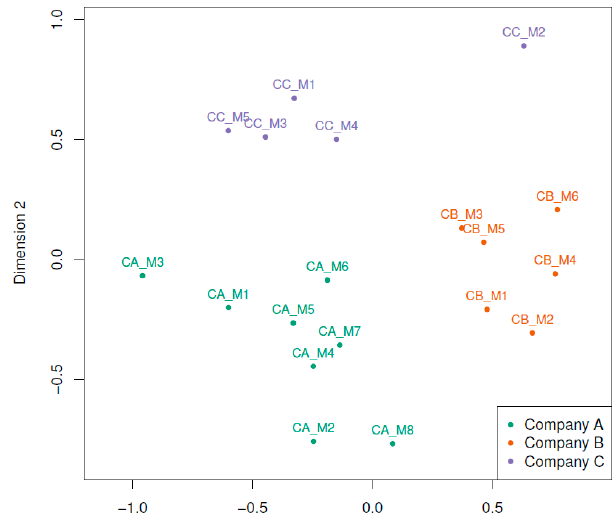
Figure 3. MDS configurations on full dataset.